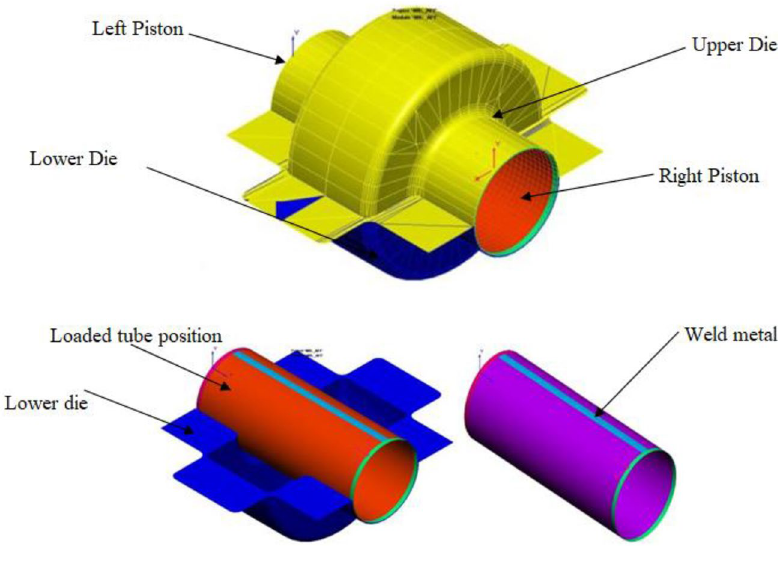
Fig. 2 Simulation setup and tube loading position on lower